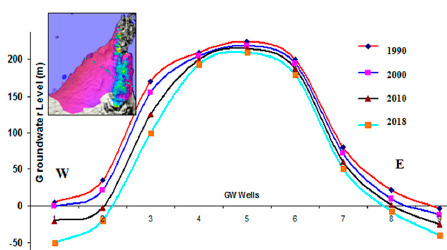
Figure 10. E-W hydrological profile constructed from hydrological information collected from selected groundwater wells showing the spatial and temporal variations of groundwater level for the years 1990, 2000, 2010, and 2018.